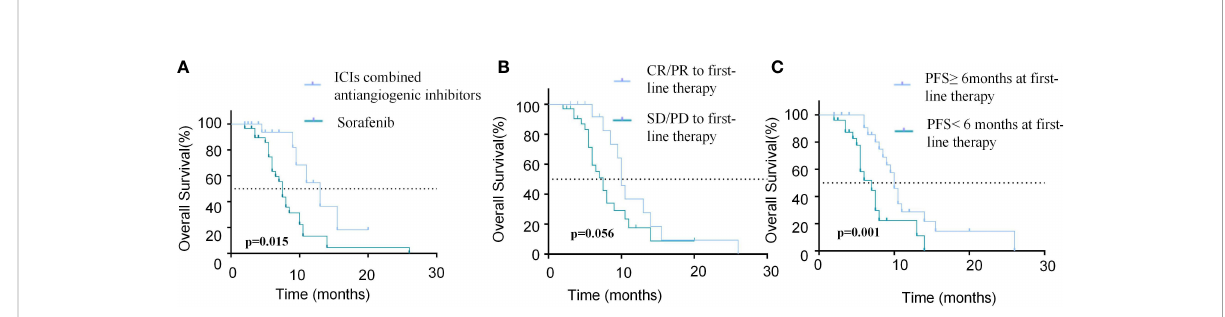
FIGURE 5 Comparison of OS in patients with different modalities and ef fi cacy of fi rst-line treatment. (A) Kaplan-Meier curves of OS between patients with ICIs combined antiangiogenic inhibitors or sora fi nib for the fi rst-line treatment. (B) Kaplan-Meier curves of OS between patients who achieved CR/PR or SD/ PD in the fi rst-line treatment. (C) Kaplan-Meier curves of OS between patients with PFS ≥ 6months or PFS<6months in the fi rst-line